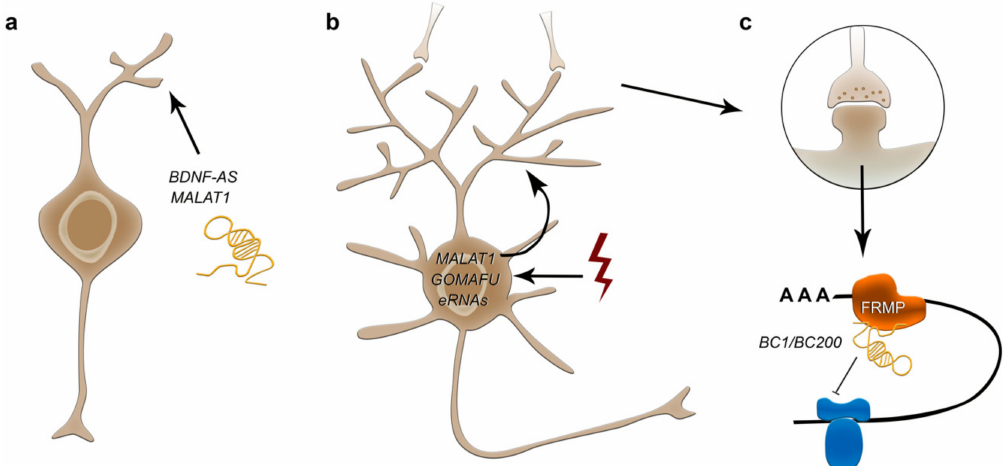
Figure 3. Potential roles of lncRNA in neurite outgrowth ( a ), activity induced synaptic function ( b )